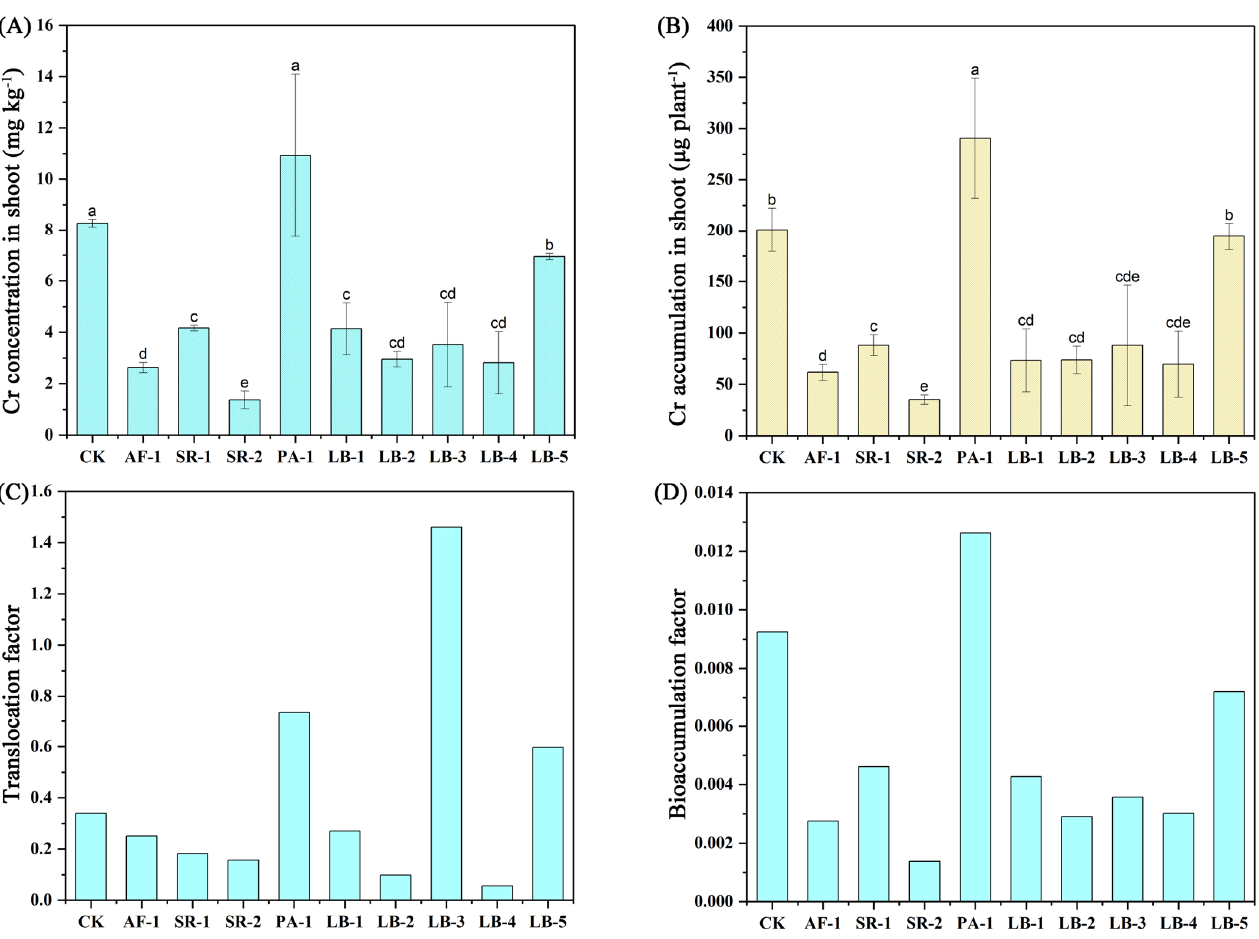
Figure 4. The Cr uptake, translocation and bioaccumulation of plants in different treatments. The data are average of three replicates ± SE. ( A ): Cr concentration in shoot; ( B ): Cr accumulation in shoot; ( C ): Translocation factor; ( D ): Bioaccumulation factor. The same le(cid:308)er means no significant difference.